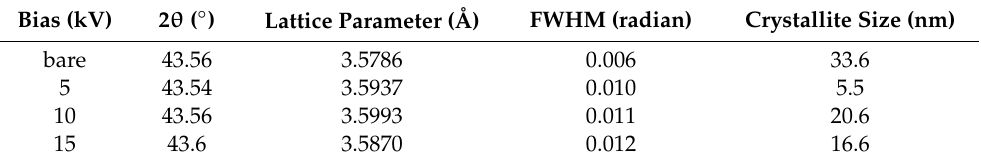
Figure 7. X-ray Diffraction (XRD) patterns of N + -implanted samples as a function of implantation voltages. Table 4. The conducted parameter for (111) plane from XRD patterns of 316L bare and N + -implanted